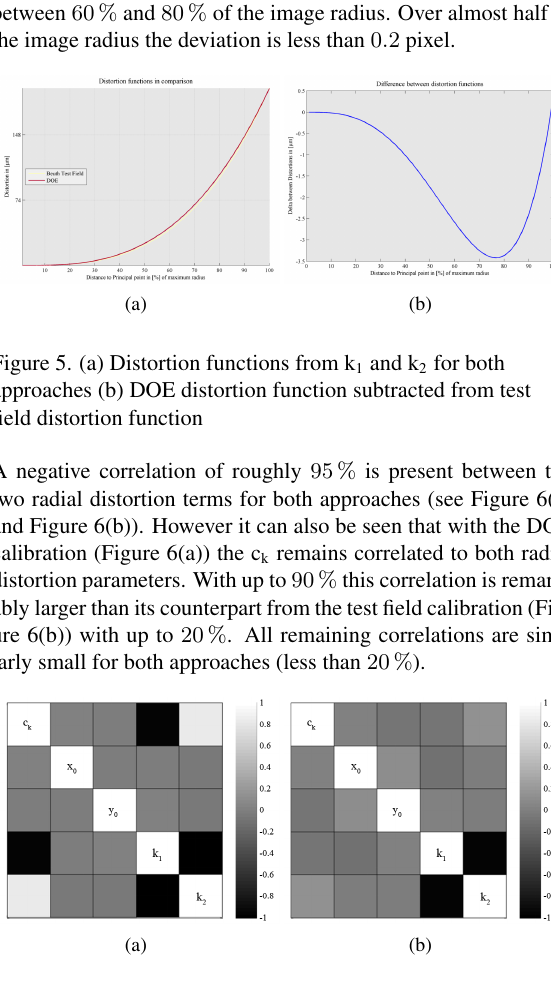
Figure 6. Covariances between intrinsic parameters. (a) Covariance plot for DOE calibration (b) Covariance plot for test field